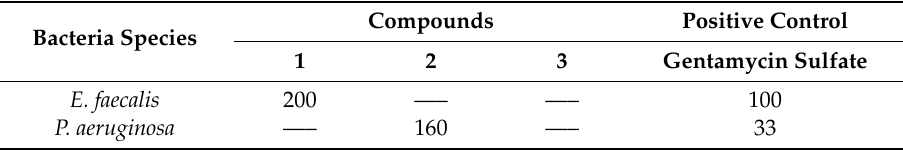
Table 4. Antibacterial activities of compounds 1 – 3 , MIC ( µ